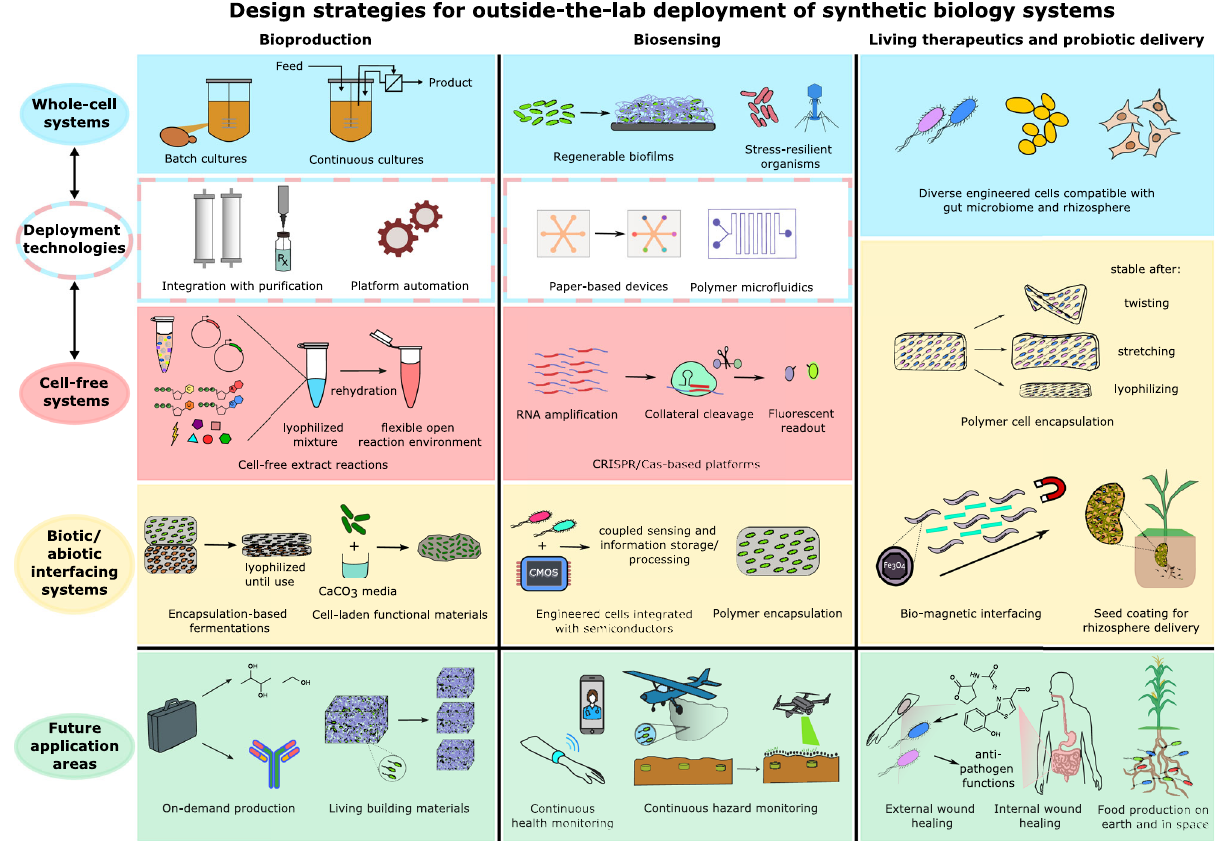
Fig. 2 Design strategies for outside-the-lab deployment of synthetic biology systems. This Perspective encompasses design strategies for deploying synthetic biology outside-the-lab, which vary based on the particular system type (whole-cell (blue), cell-free (red), biotic/abiotic interfacing (yellow)) and application space (bioproduction, biosensing, living therapeutics, and probiotic delivery; all in green). Outside-the-lab bioproduction design strategies include whole-cell liquid cultures, cell-free extract reactions, and encapsulation platforms interfacing living cells with materials, with widespread future applications including on-demand production of small molecules and biologic therapeutics as well as regenerable living building materials. Outside-the-lab biosensing design strategies include whole-cell engineered stress-resilient organisms and regenerable bio fi lms, cell-free CRISPR/Cas-based sensing platforms, as well as interfacing living cells with novel polymer and electronic systems, with broad future applications including continuous health and hazard monitoring. For bioproduction and biosensing, both whole-cell and cell-free systems are typically interfaced with deployment technologies, such as platform automation and micro fl uidic liquid handling, to facilitate outside-the-lab usability. Outside-the-lab closed-loop living therapeutics and probiotic delivery design strategies include whole-cell engineered microbes and mammalian cells compatible with the gut and soil microbiomes, as well as interfacing living cells with materials and magnetic systems, with future applications ranging from wound healing to continuous food production on earth and in